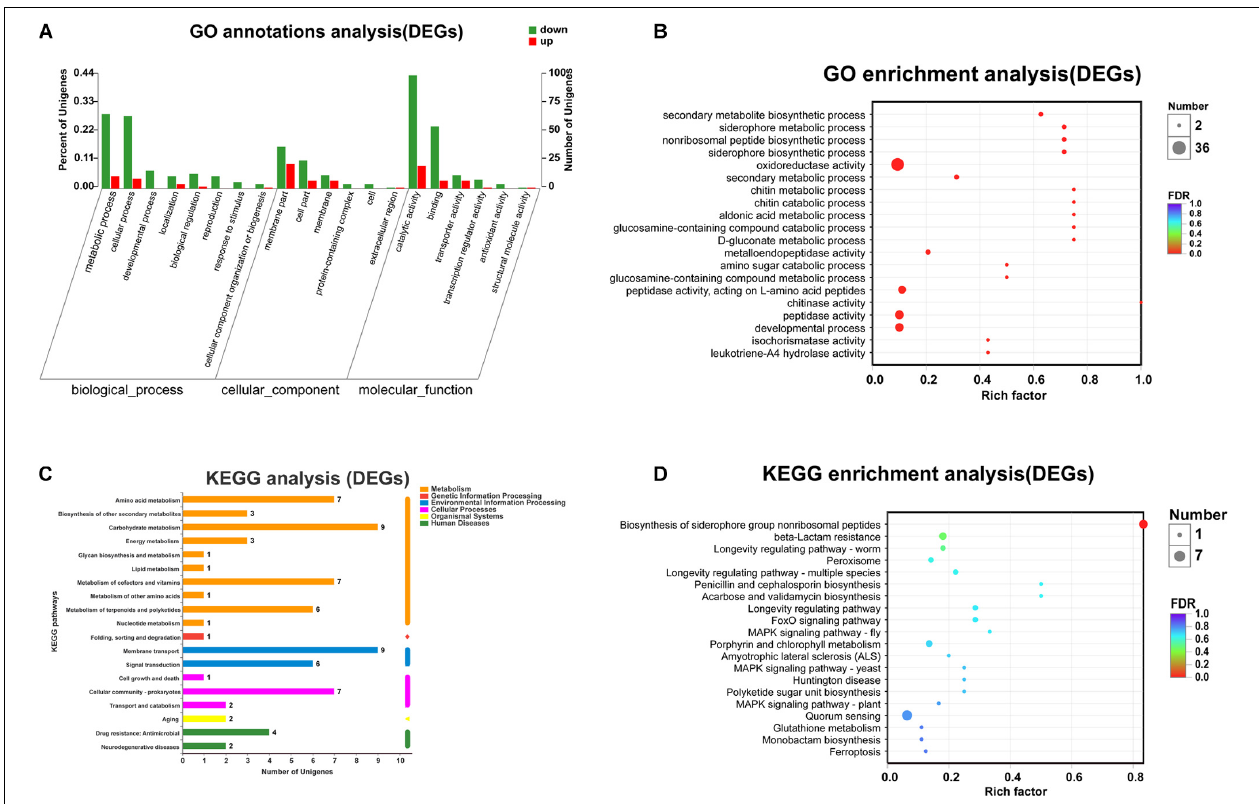
FIGURE 2 | Functional annotation of the DEGs in the mutant and reference strains. (A) Top 20 terms of GO annotations. Red and green columns represent the number of upregulated and downregulated unigenes in GO terms, respectively. (B) GO functional enrichment analysis (The 20 most enriched GO terms). (C) KEGG pathway annotations. (D) KEGG pathway enrichment analysis. “Rich factor” means that the ratio of the DEGs number and the number of genes has been annotated in this term or pathway. The greater the Rich factor, the greater the degree of enrichment. The size of each point indicates the number of differentially expressed genes in that term